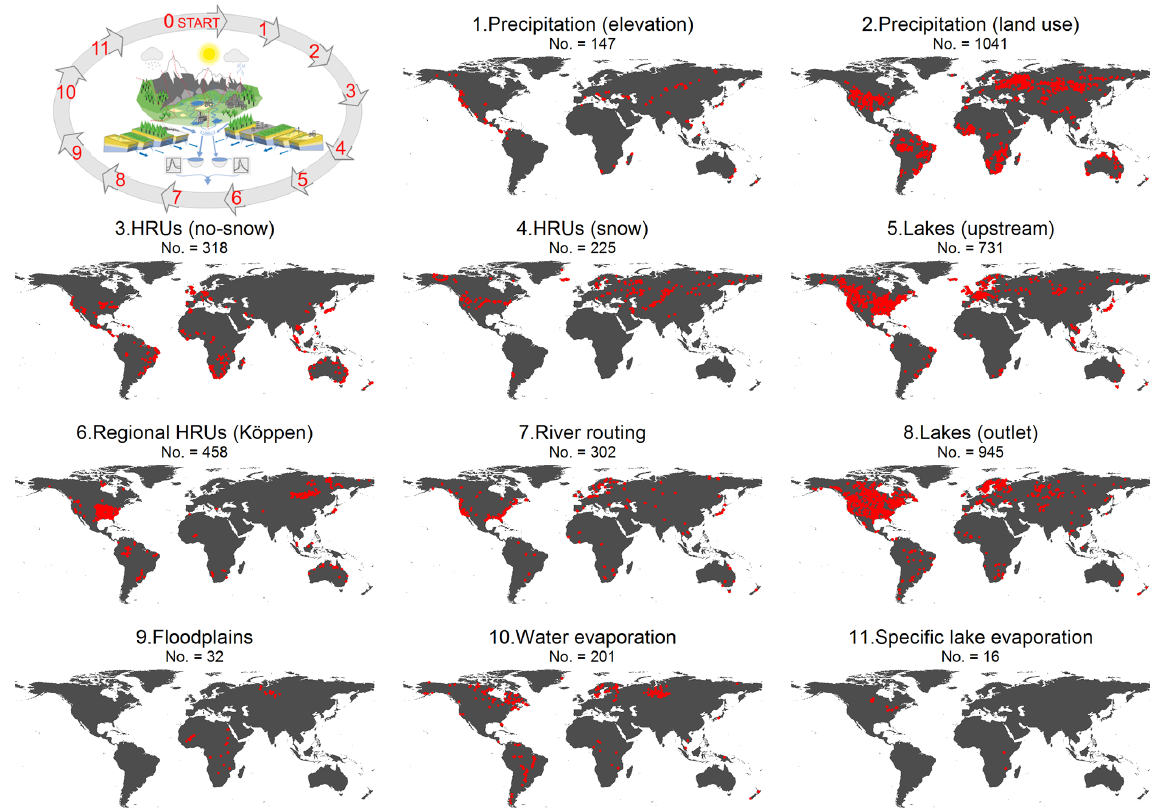
Figure 3. Number of gauging stations and their locations that were used in each step of the stepwise parameter estimation procedure and evaluation against in situ observations